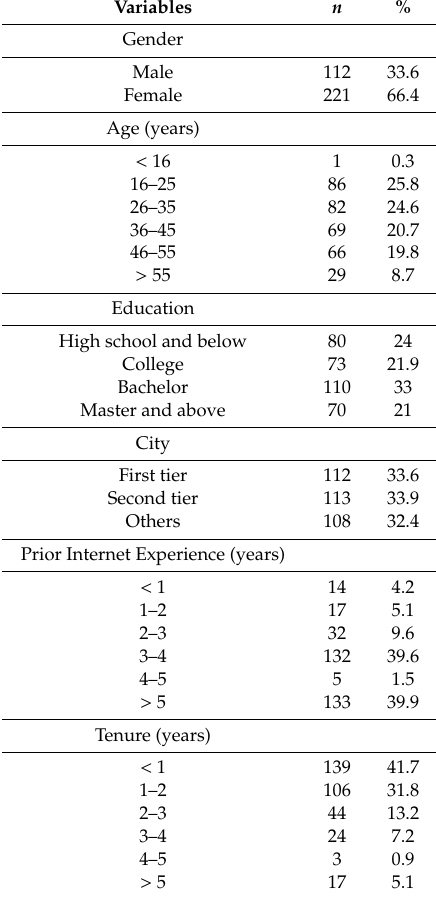
Table 2. Descriptive statistics ( n =